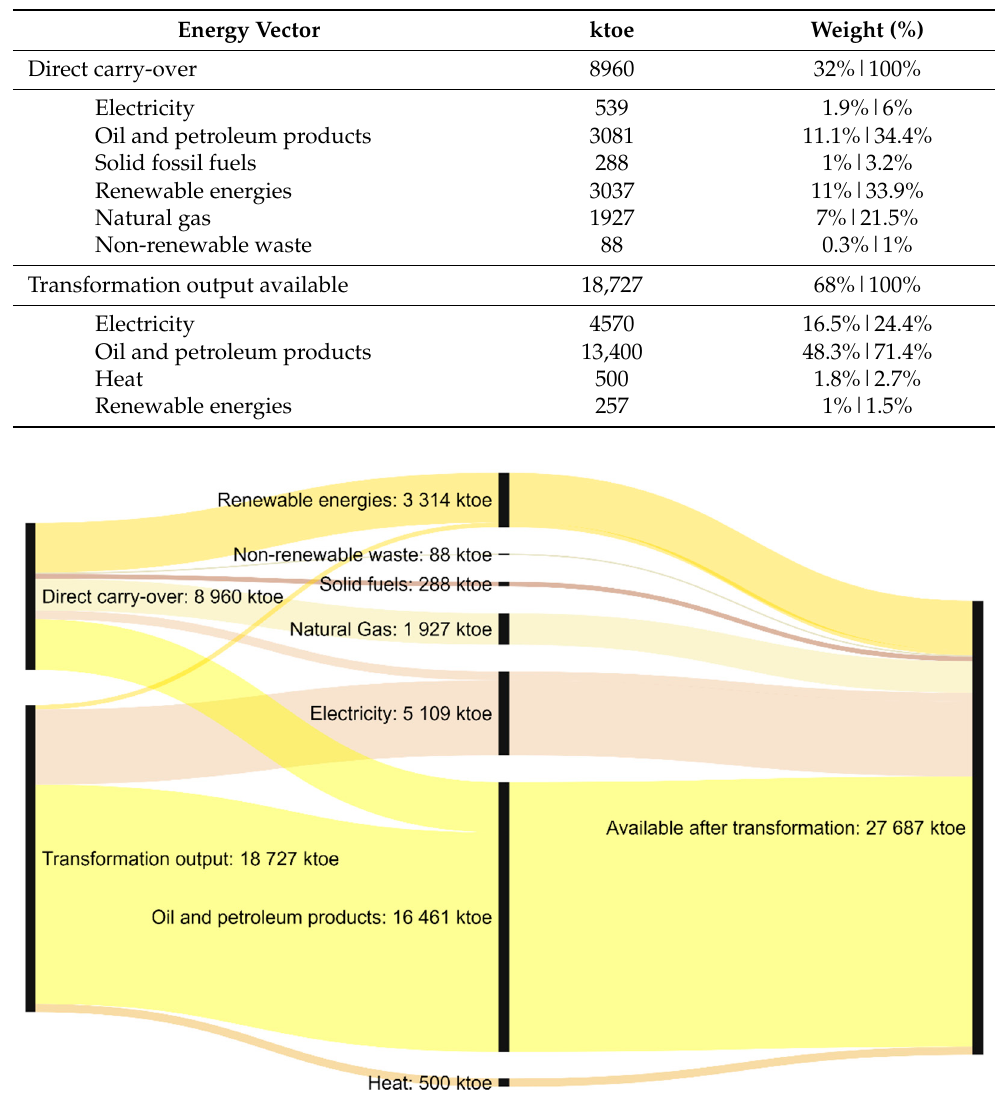
Figure 16. Portuguese energy balance flow for energy available after transformation–2019 data (adopted from Eurostat data).